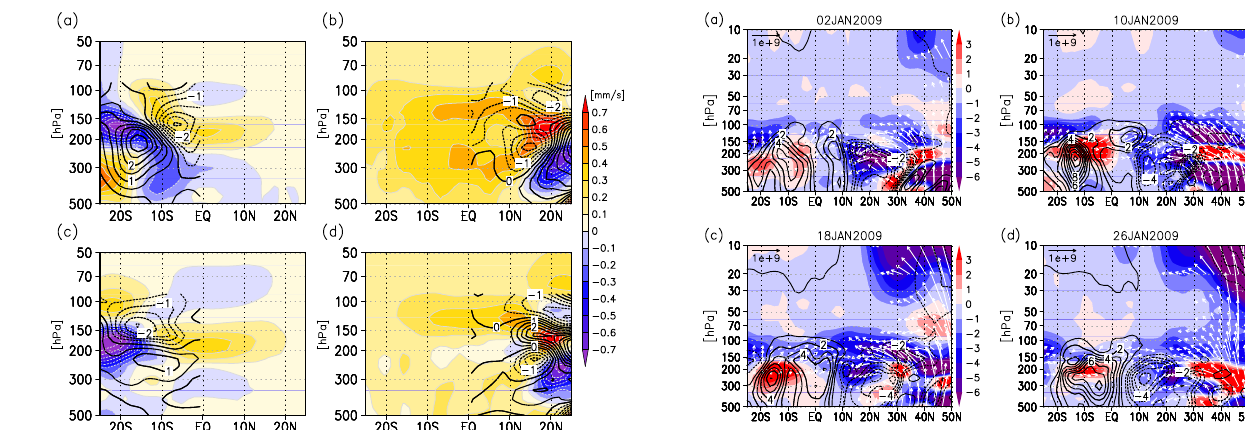
Fig. 8. As for Fig. 7, except for (left) forcing in the southern hemi- spheric troposphere and (right) northern hemispheric troposphere. Contour interval is 0.5ms − 1 d − 1 . Divergences of the EP flux and F (z) above 80hPa are not shown. See Table 1 for details. 1